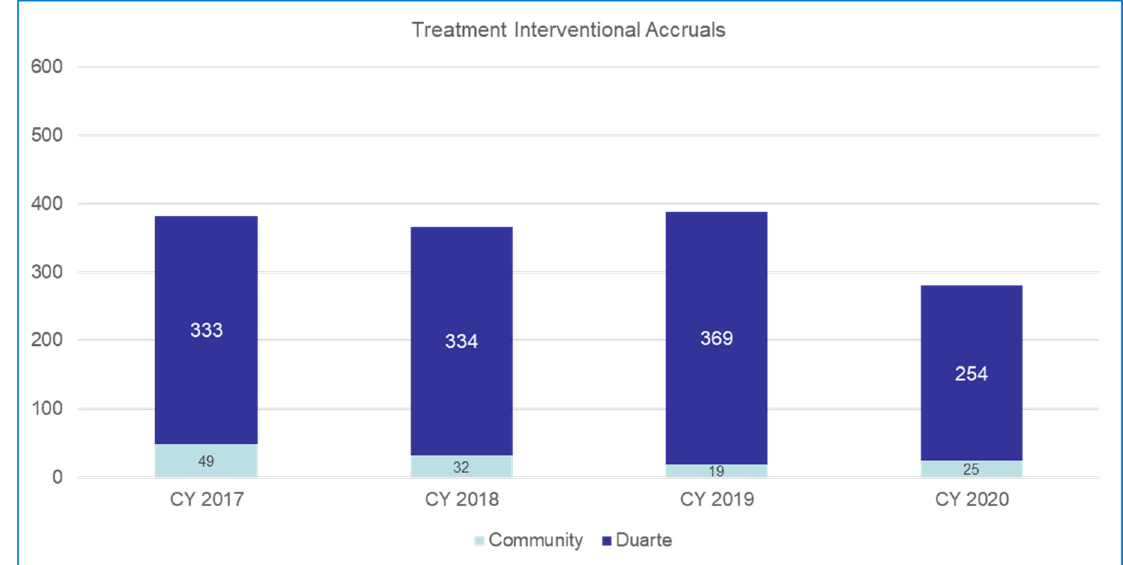
Figure 3. Clinical trial accrual at Duarte and community sites 2017 through September 2020 . Light blue bars are the number of patients accrued to treatment trials at community sites where some trials were available. Dark blue bars are number of patients accrued to treatment trial at the Duarte academic campus.